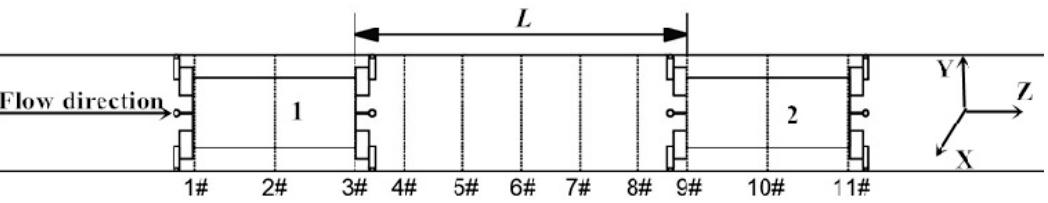
Figure 7. The layout of measuring cross-sections. Note: 1. Rear pipe vehicle. 2. Front pipe vehicle. L represents the two-pipe vehicle spacing. 1#~11# represent the measuring cross-sections. For the annular gap flow field, five measuring rings were arranged, and the measuring ring radii were r 1 = r c + 1 / 5 d , r 2 = r c + 2 / 5 d , r 3 = r c + 1 / 2 d , r 4 = r c + 3 / 5 d , r 4 = r c + 4 / 5 d (r c is the radius of the pipe